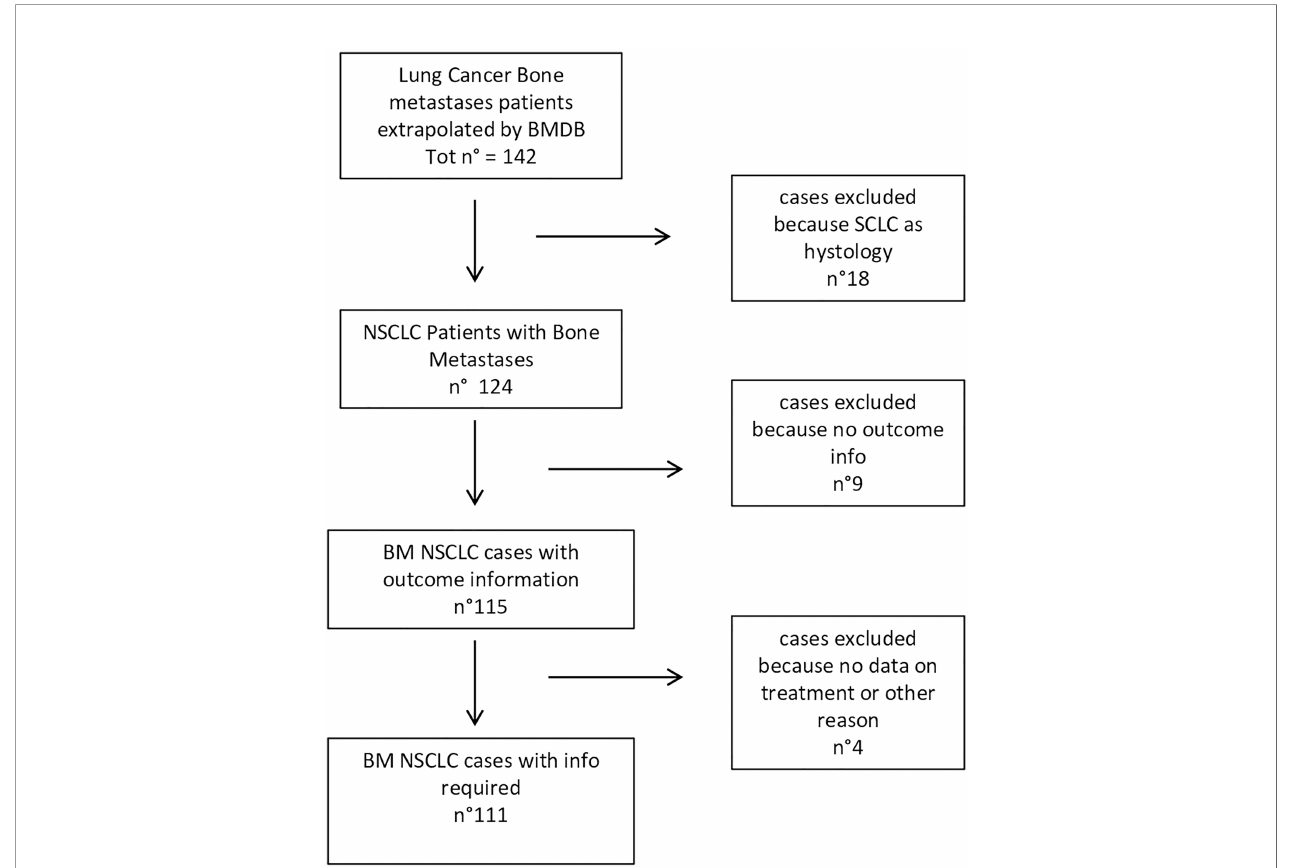
FIGURE 1 | Flow chart of patient